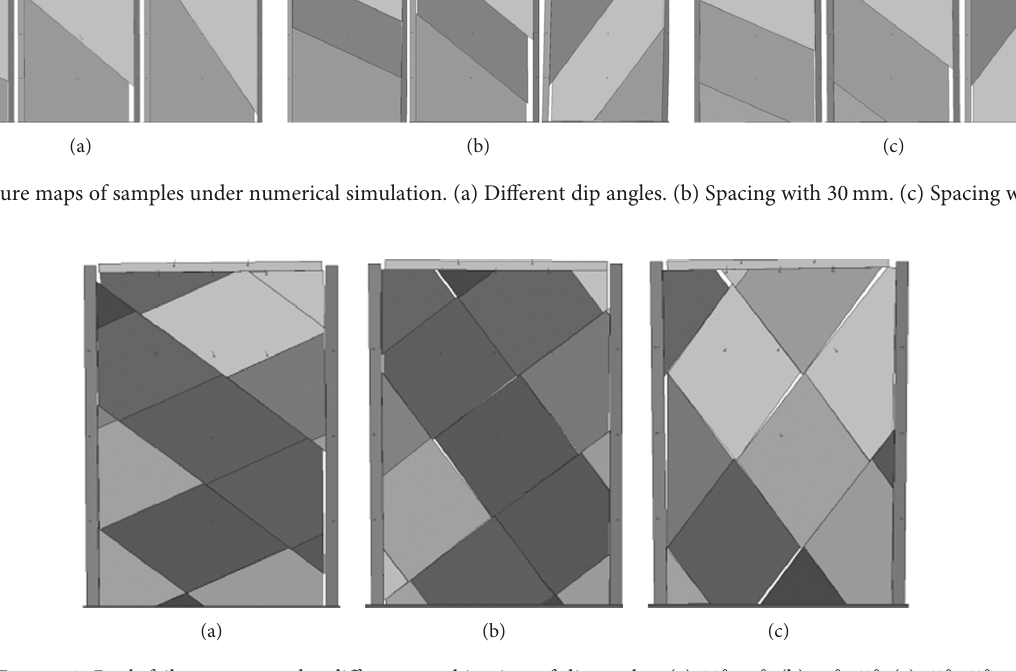
Figure 2: Rock failure maps under different combination of dip angles. (a) 30 ° –45 ° . (b) 45 ° –60 ° . (c) 60 ° –60 °